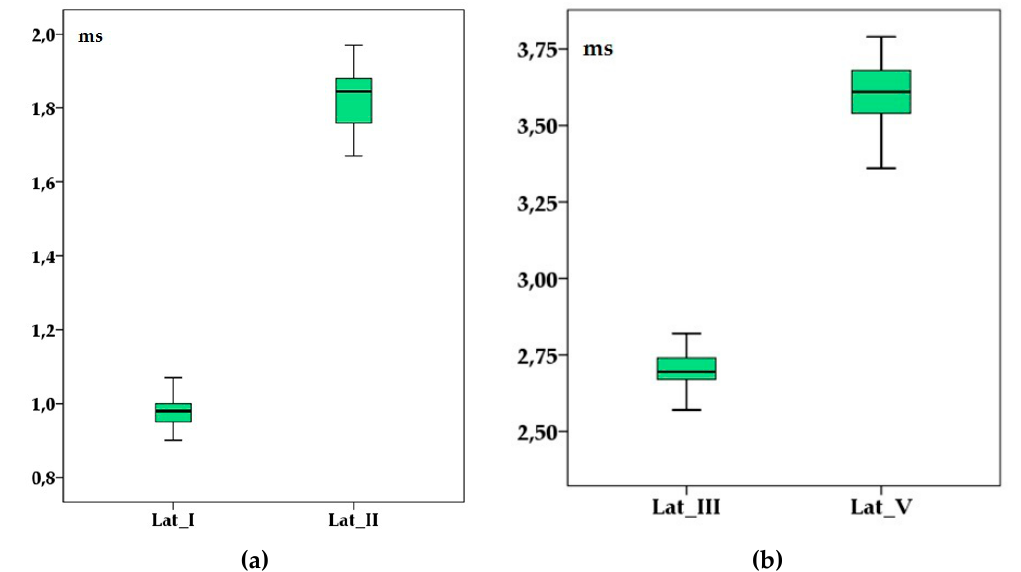
Figure 2. Brainstem auditory evoked response’ latencies (in milliseconds) of wave I and II ( a ) and III and V ( b ) in adult healthy raccoon dogs after a 90 dB sound pressure level (SPL) stimulus was applied. Boxplots represent the cumulative values from all individuals after two consecutive left, right and binaural stimulations. Lat_I—wave I latency; Lat_II—wave II latency; Lat_III—wave III latency; Lat_V—wave V latency.